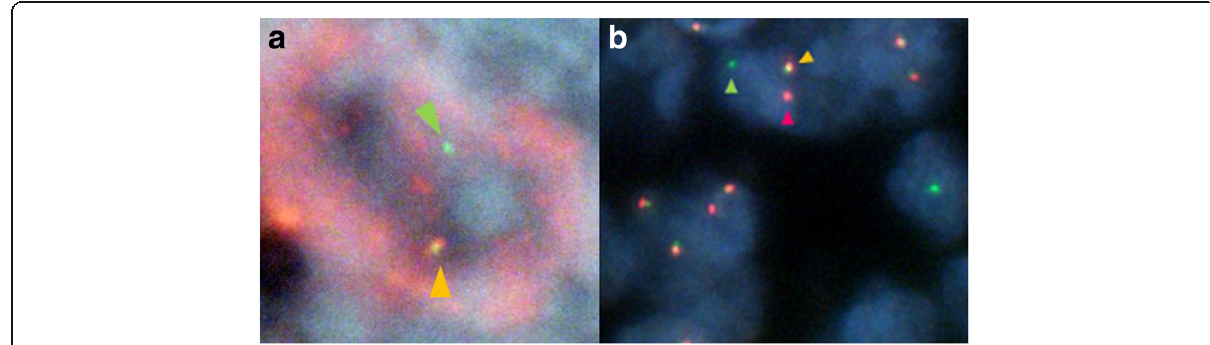
Fig. 3 Fluorescence in situ hybridization (FISH) findings of each post-transplant lymphoproliferative disorder (PTLD). a FISH of monomorphic B cell (follicular lymphoma type) PTLD. The split signals (green and yellow triangles) indicating a rearrangement of BCL6 in the tumor cell. b Double labeling detection method that combines FISH for rearrangement of BCL6 and immunohistochemical staining for CD30 of classical Hodgkin lymphoma-type PTLD. In the Hodgkin cells, there were the split signals (green and yellow triangles) indicating a rearrangement of BCL6, and the other signal (red triangle) indicating an immunohistochemical positivity for